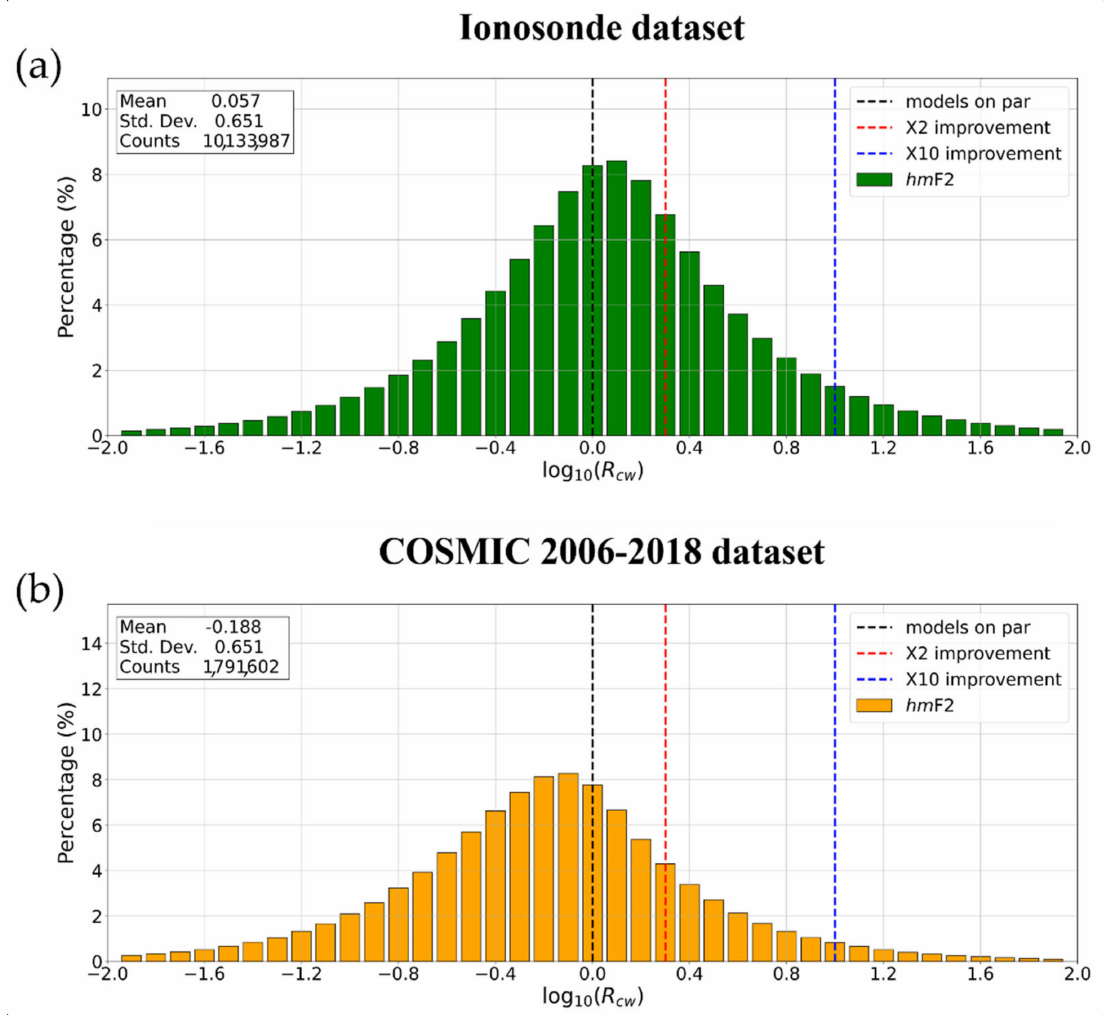
Figure 46. Same as Figure 45 but for hm